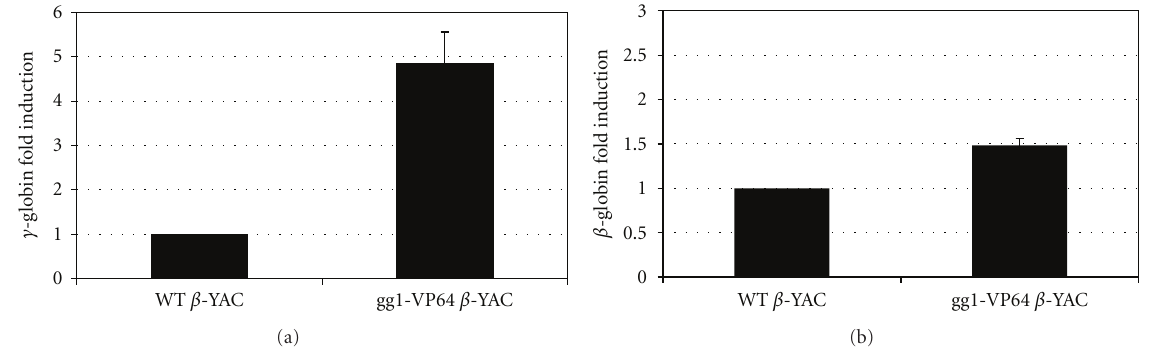
Figure 2: Human β -like globin gene expression in adult blood samples from gg1-VP64 β -YAC transgenic mice. Total RNA isolated from adult blood was subjected to qPCR analysis using SYBR Green. Primers for human γ - and β -globin were utilized, and the data was normalized to mouse α -globin or Gapdh gene expression. (a) γ -globin gene expression. (b) β -globin gene expression. Results are the average of 7 di ff erent gg1-VP64 β -YAC bigenic mice ± the standard error of the mean (SEM). Student’s t -test values were P < 0 . 01 for γ -globin and P > 0.1 for β